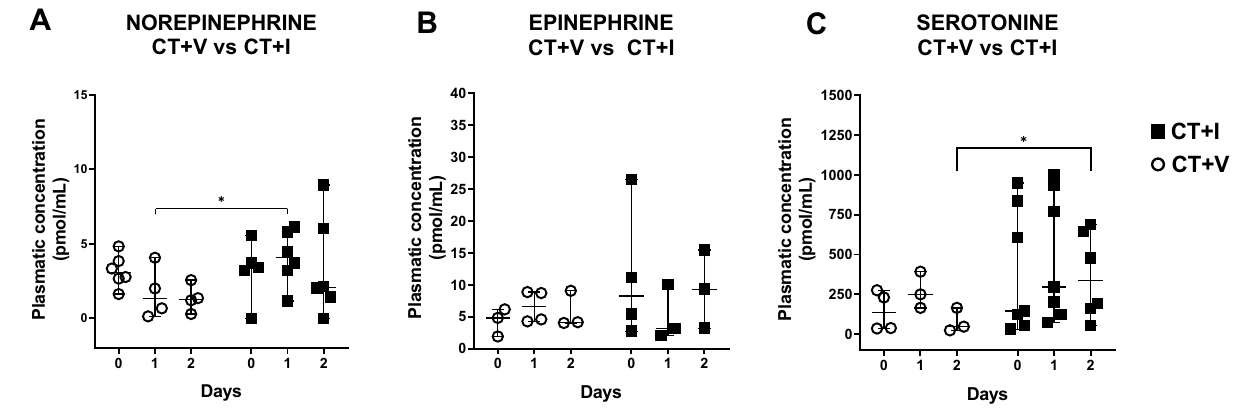
Figure 5. Effect of the immunomodulator over the plasma neurotransmitter concentration of puppies affected by CPE. ( A ) Norepinephrine: A significant increase was observed in the CT + I group on day 1 of evaluation with respect to the CT + V group. ( B ) Epinephrine: No significant differences were observed between groups. ( C ) Serotonin: A considerable decrease was found in CT + V as compared to CT + I on day 2. Kruskal–Wallis test and Dunn’s post-hoc test were carried out. Each dot represents a puppy. Median ± 5–95% confidence interval. *P ≤ 0.05. CT conventional treatment, I immunomodulatory, V vehicle.